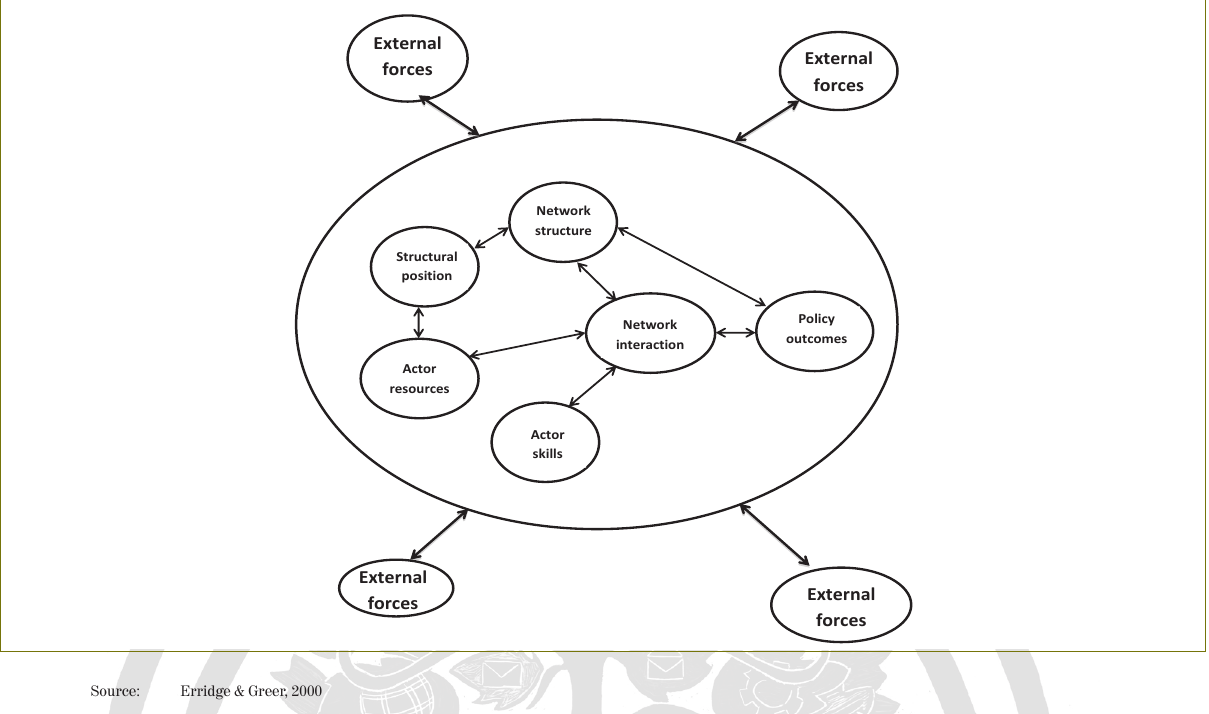
FIGURE 1: ELEMENTS AND RELATIONSHIPS OF POLICY